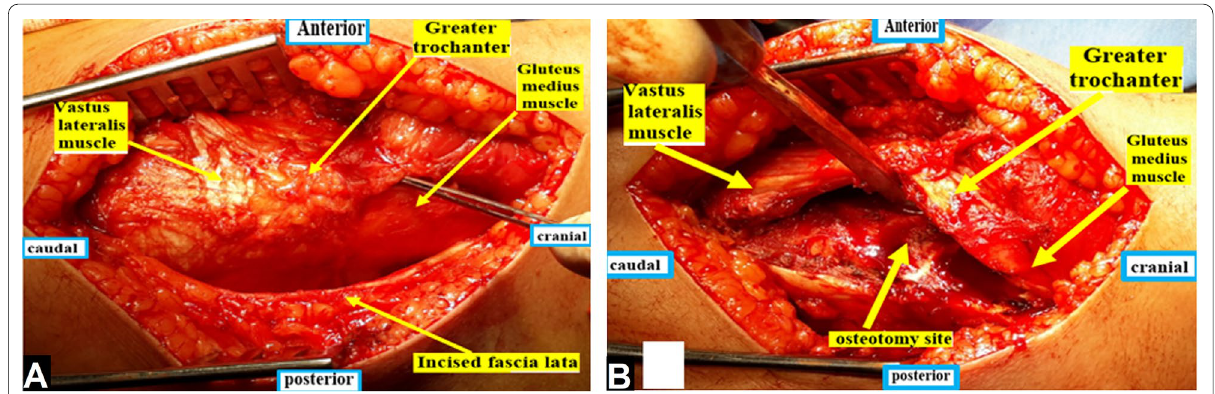
Fig. 3 A Straight lateral skin incision and superficial dissection. B Greater trochanteric osteotomy